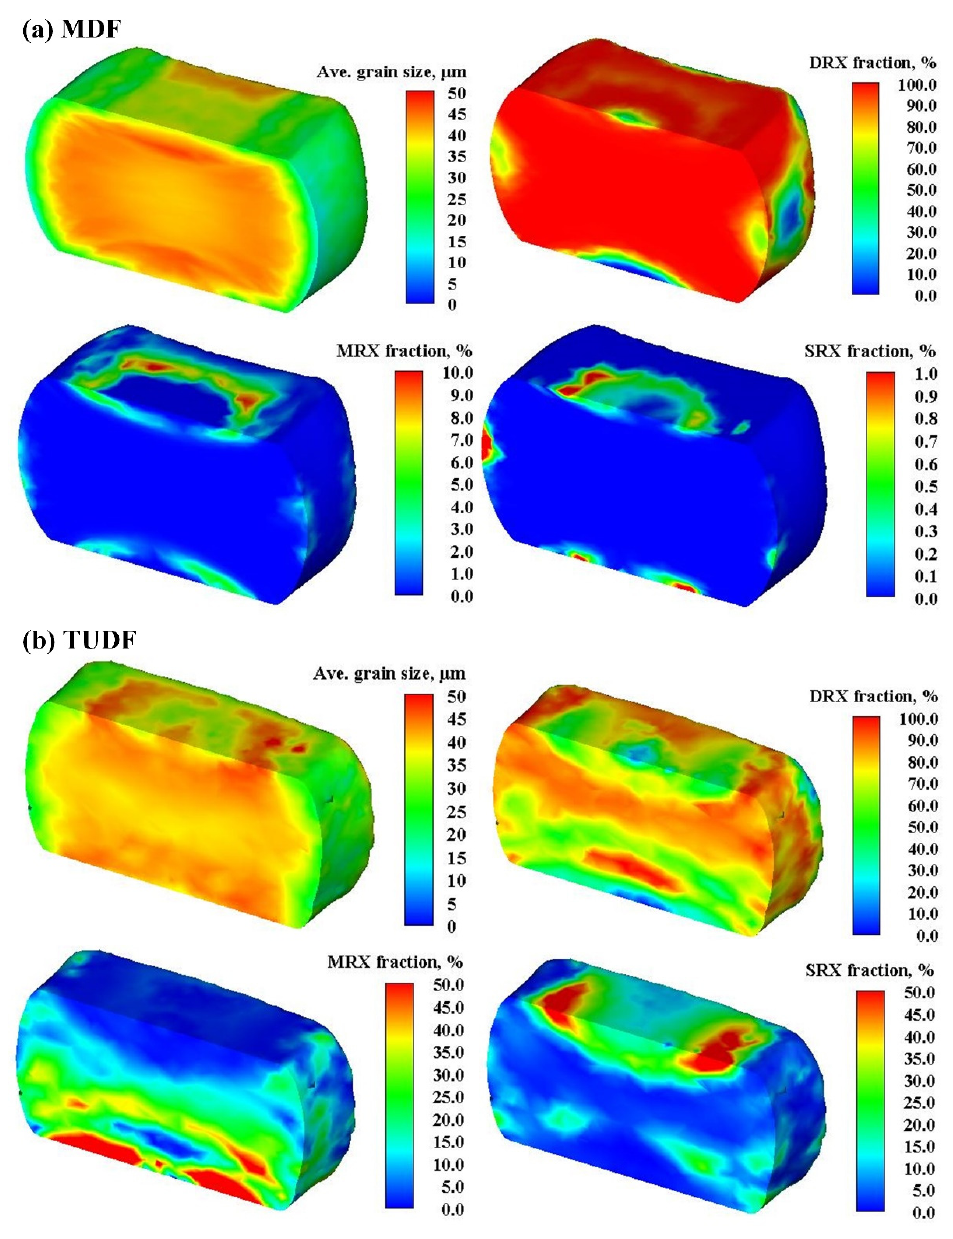
Figure 17. Microstructural distribution contours for the ( a ) MDF and ( b ) TUSF specimens. The initial grain sizes at P1, P2 and P3 in the MDF specimen were 39, 40 and 17 µ m, and the final grain sizes were 36, 40 and 14 µ m, respectively (Figure 18). The grain size at P2 was almost unchanged, and that at P1 and P3 decreased significantly, possibly because the deformation on the side surface was relatively large, and the grains on the surface were easily broken. However, the temperature of the core remained at the initial temperature of 1150 ◦ C, the grain plasticity was good, and the grains would not fracture during plastic deformation. On the other hand, the initial grain sizes at P1, P2 and P3 on the TUSF specimen were 46, 39 and 41 µ m, and the final grain sizes were 42, 39 and 24 µ m, respectively. After further treatment, the grain structure at P2 remained unchanged, and the average grain size was 39 µ m. There are more variations in the average grain size and DRX volume fraction in the TUSF specimen (Figure 18b), attributed to the uneven distribution of grain size and DRX during